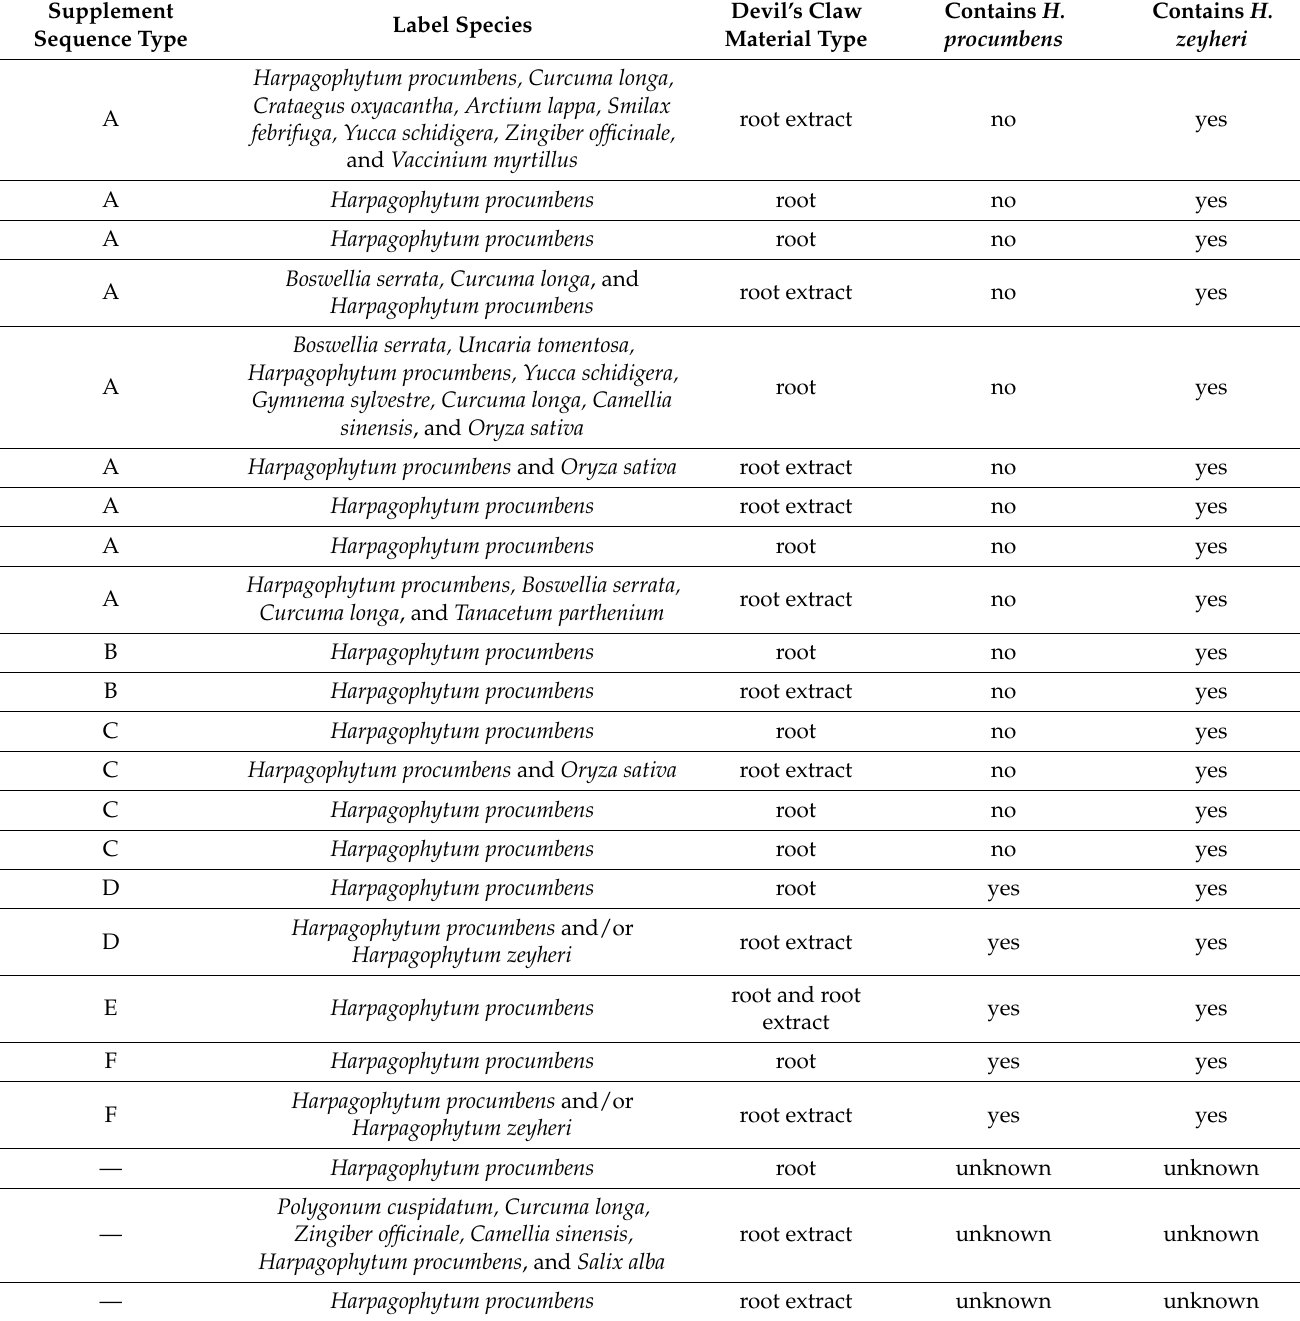
PCR products were successfully sequenced for all 20 amplifiable supplements: mini-